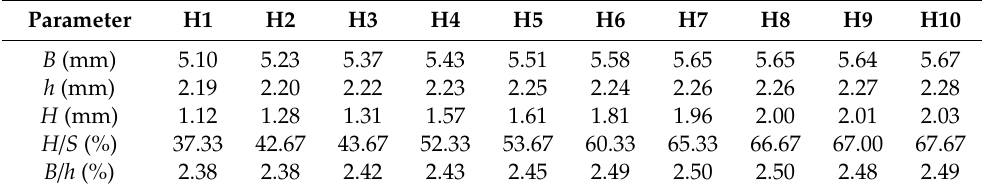
Table 6. Measurement of geometry characteristic parameters under backward inclination